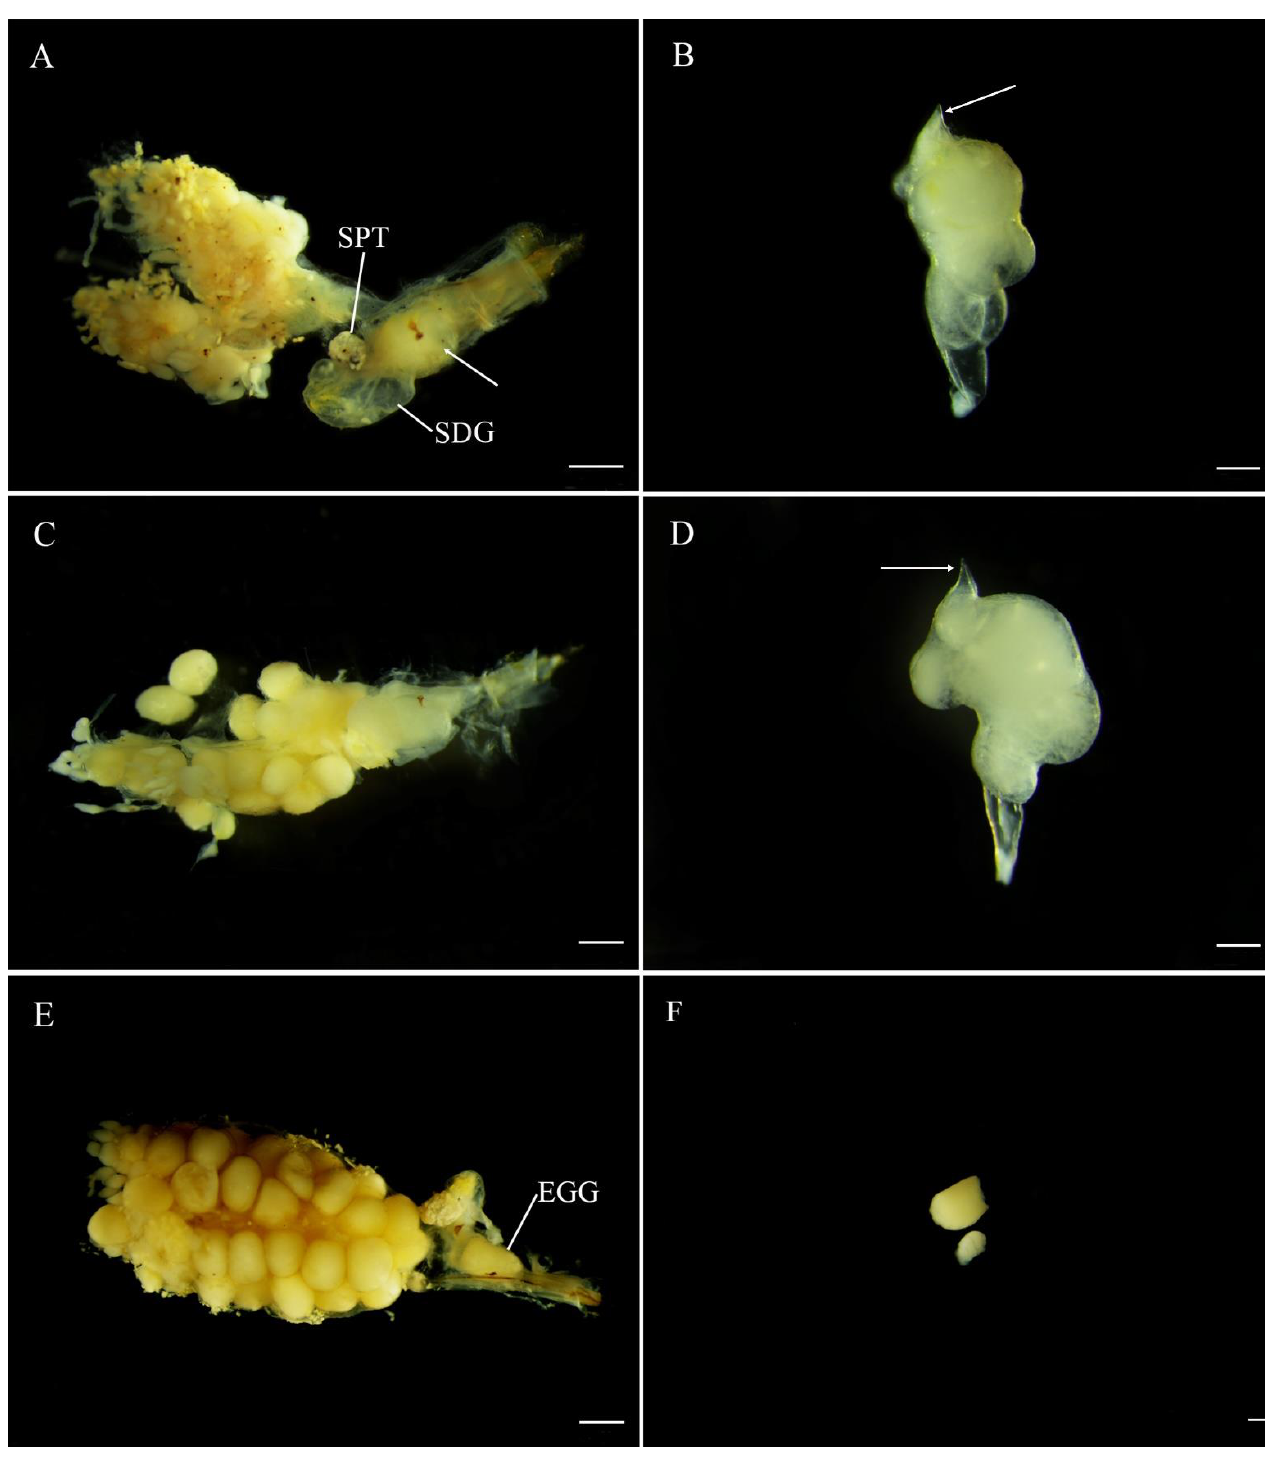
Figure 6. Position and digestion of male spermatophore in bursa copulatrix of Abscondita chinensis at various times after copulation. ( A ) Thirty minutes after copulation: female reproductive system with male spermatophore indicated by while arrow in its bursa copulatrix (female accessory gland removed). ( B ) Thirty minutes after copulation: intact male spermatophore dissected from female bursa copulatrix. ( C ) Twenty-four hours after copulation: spermatophore entering spermatophore-digesting gland. ( D ) 24 h after copulation: Intact spermatophore dissected from female bursa copulatrix. ( E ) Forty-eight hours after copulation, spermatophore partially digested in spermatophore-digesting gland. ( F ) Forty-eight hours after copulation: partially digested spermatophore dissected from female bursa copulatrix. Figure legend: SDG, spermatophore-digesting gland; SPT, spermatheca; EGG, mature egg. Scale bars for ( A , C , E ): 0.5 mm, ( B , D , F ): 0.2 mm.